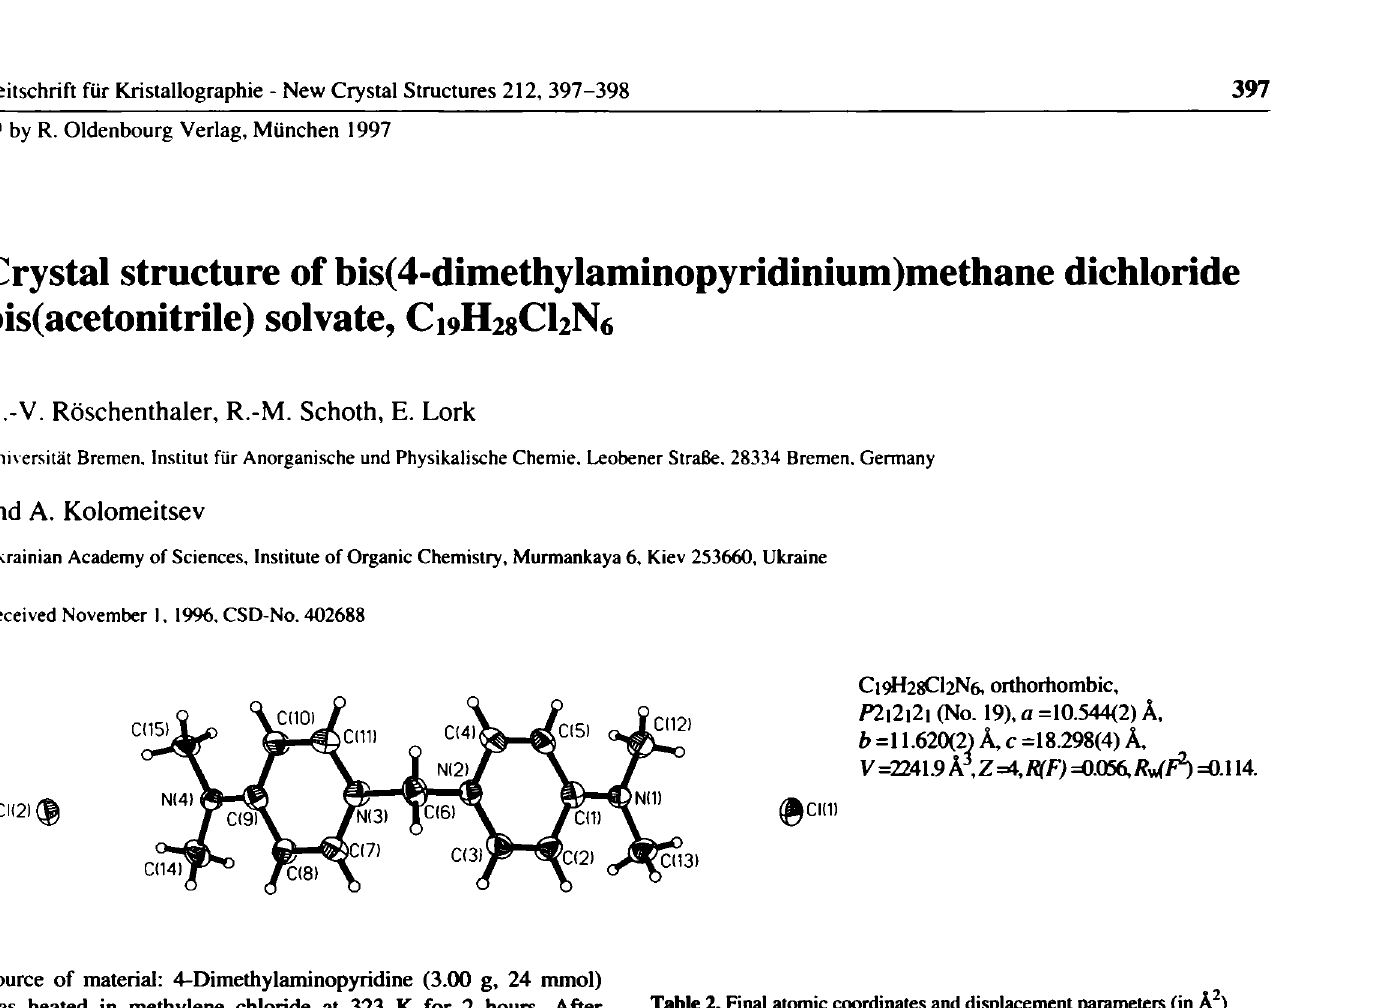
Table 2. Final atomic coordinates and displacement parameters (in Â 2